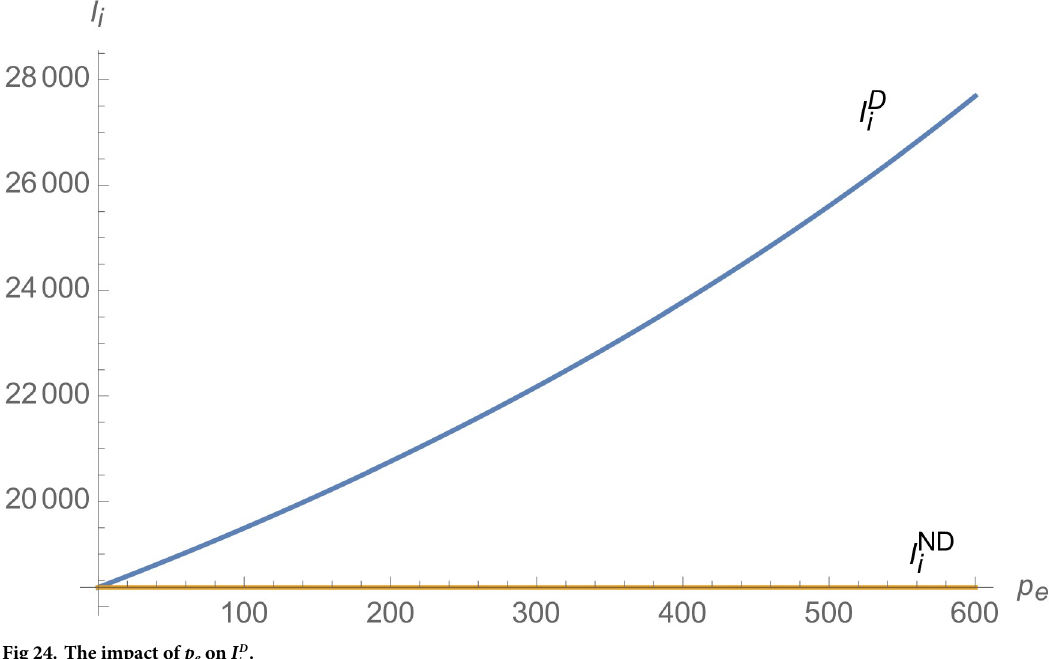
Fig 24. The impact of p e on I D